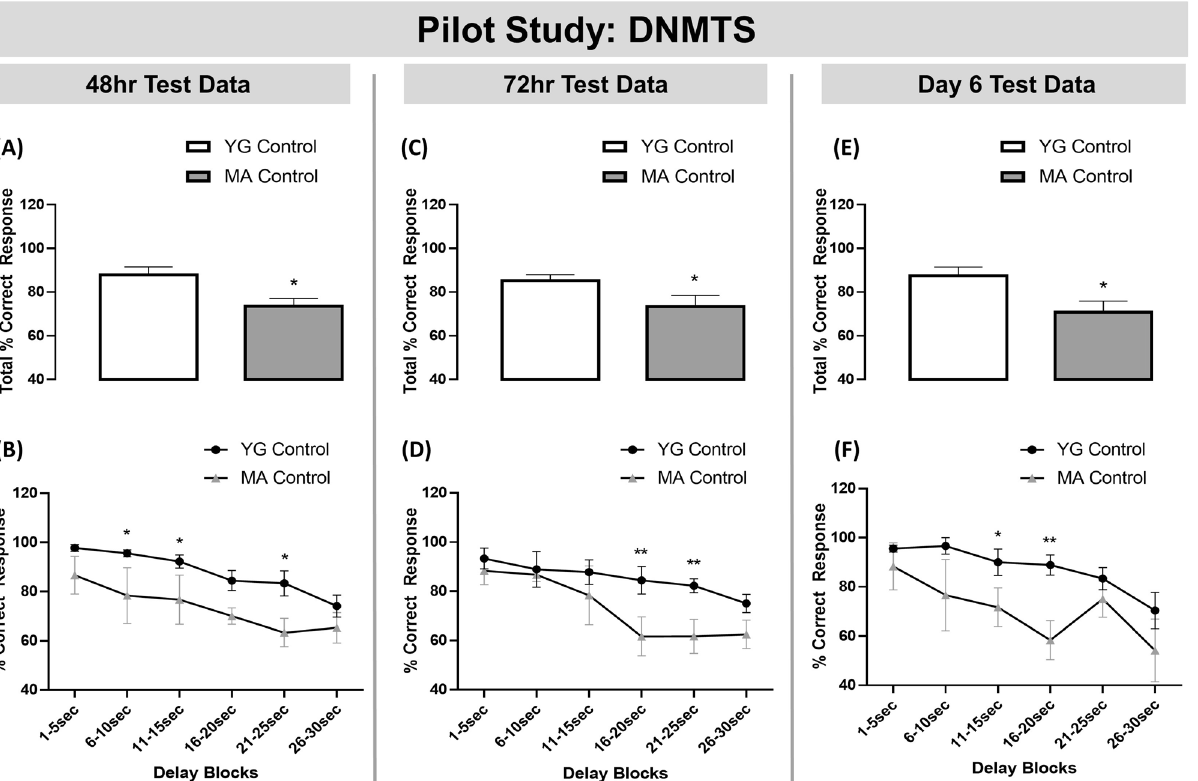
Figure 1. MA rats were impaired in the DNMTS task compared to YG controls. MA animals were impaired in the DNMTS task compared to YG controls at: ( A ) 48 h test-point overall performance; ( B ) 48 h test-point at the 6–10 s, 11–15 s to 21–25 s delay time bins; ( C ) 72 h test-point overall performance; ( D ) 72 h test-point at the 16–20 s and 21–25 s delay time bins; ( E ) Day 6 test-point overall performance; and ( F ) Day 6 test-point at the 11–15 s and 16–20 s delay time bins. Histograms represent Total % Correct response (the mean group performance across all delay lengths in the DNMTS task ± SEM), n = 4–6 per group. DNMTS trials were sorted by performance according to length of delay on individual trials and were grouped according to 5-s intervals (1–5, 6–10, 11–15, 16–20, 21–25, and 26–30) represented by line graphs (mean ± SEM). Two-way ANOVA followed by Fishers LSD analysis **p < 0.01, *p < 0.05 vs. YG